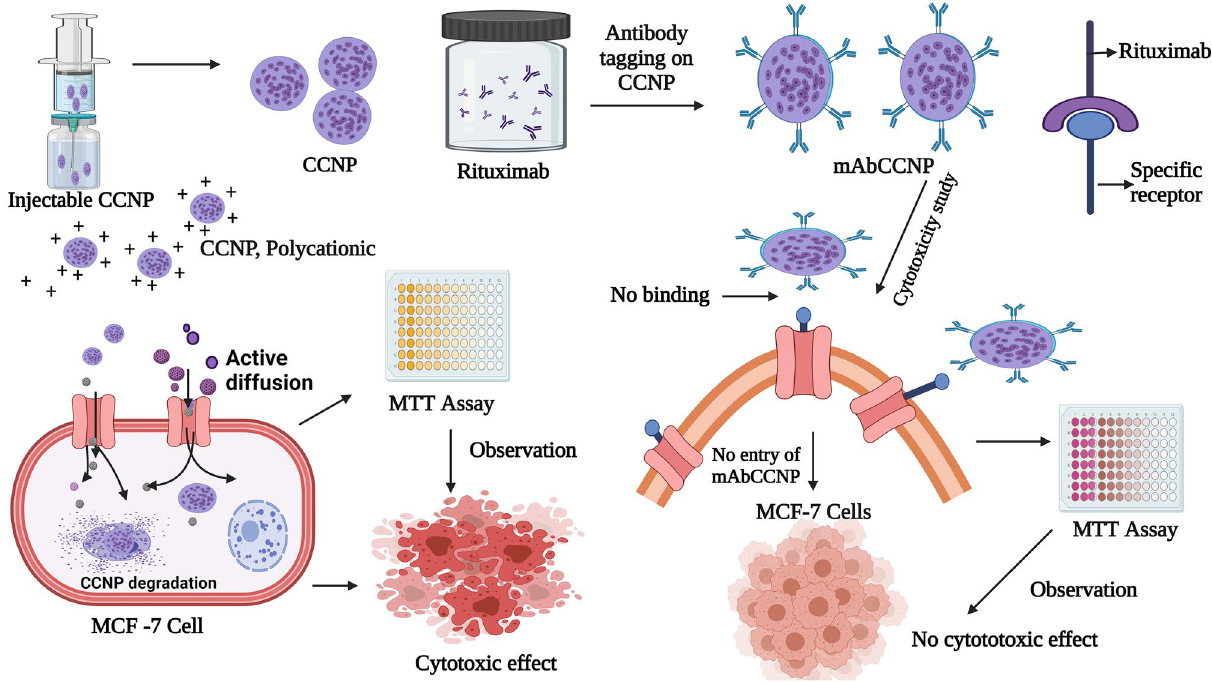
Figure 1. Schematic representation of nanoparticles developed and their mechanistic approach. *CCNP: Cisplatin loaded chitosan nanoparticles, **mAbCCNP: Rituximab surface linked cisplatin loaded chitosan nanoparticles. This figure was Created with BioRender.com, Bio Render,